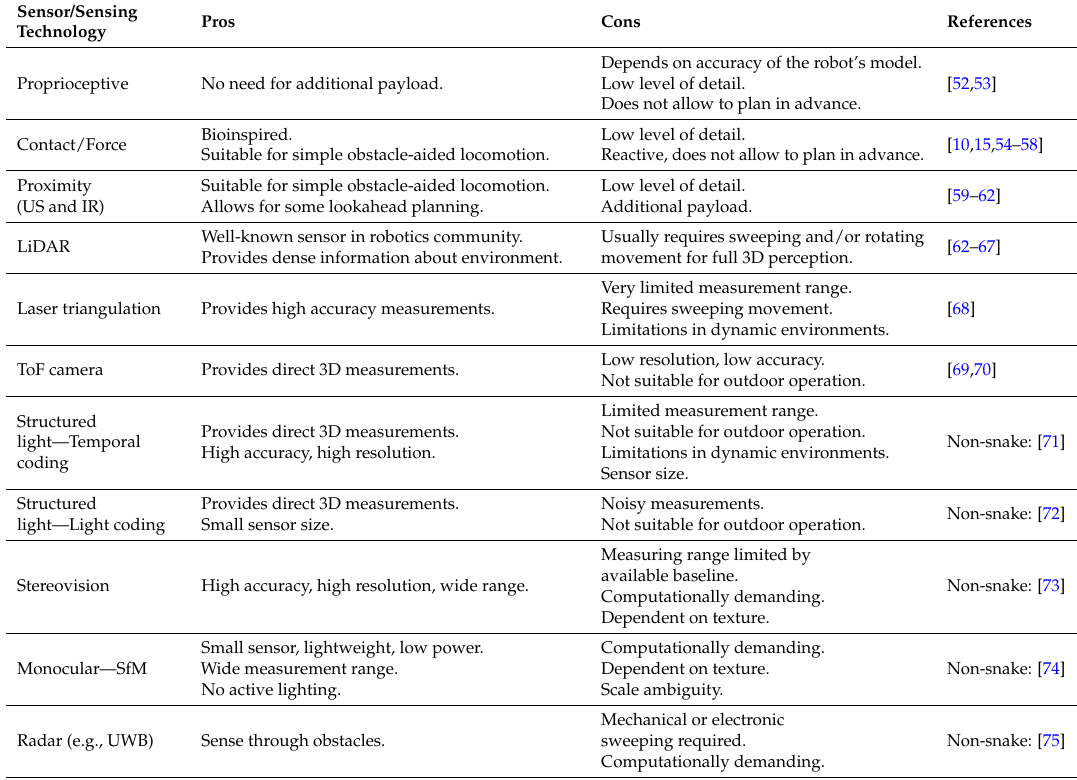
Table 2. Sensors for environment